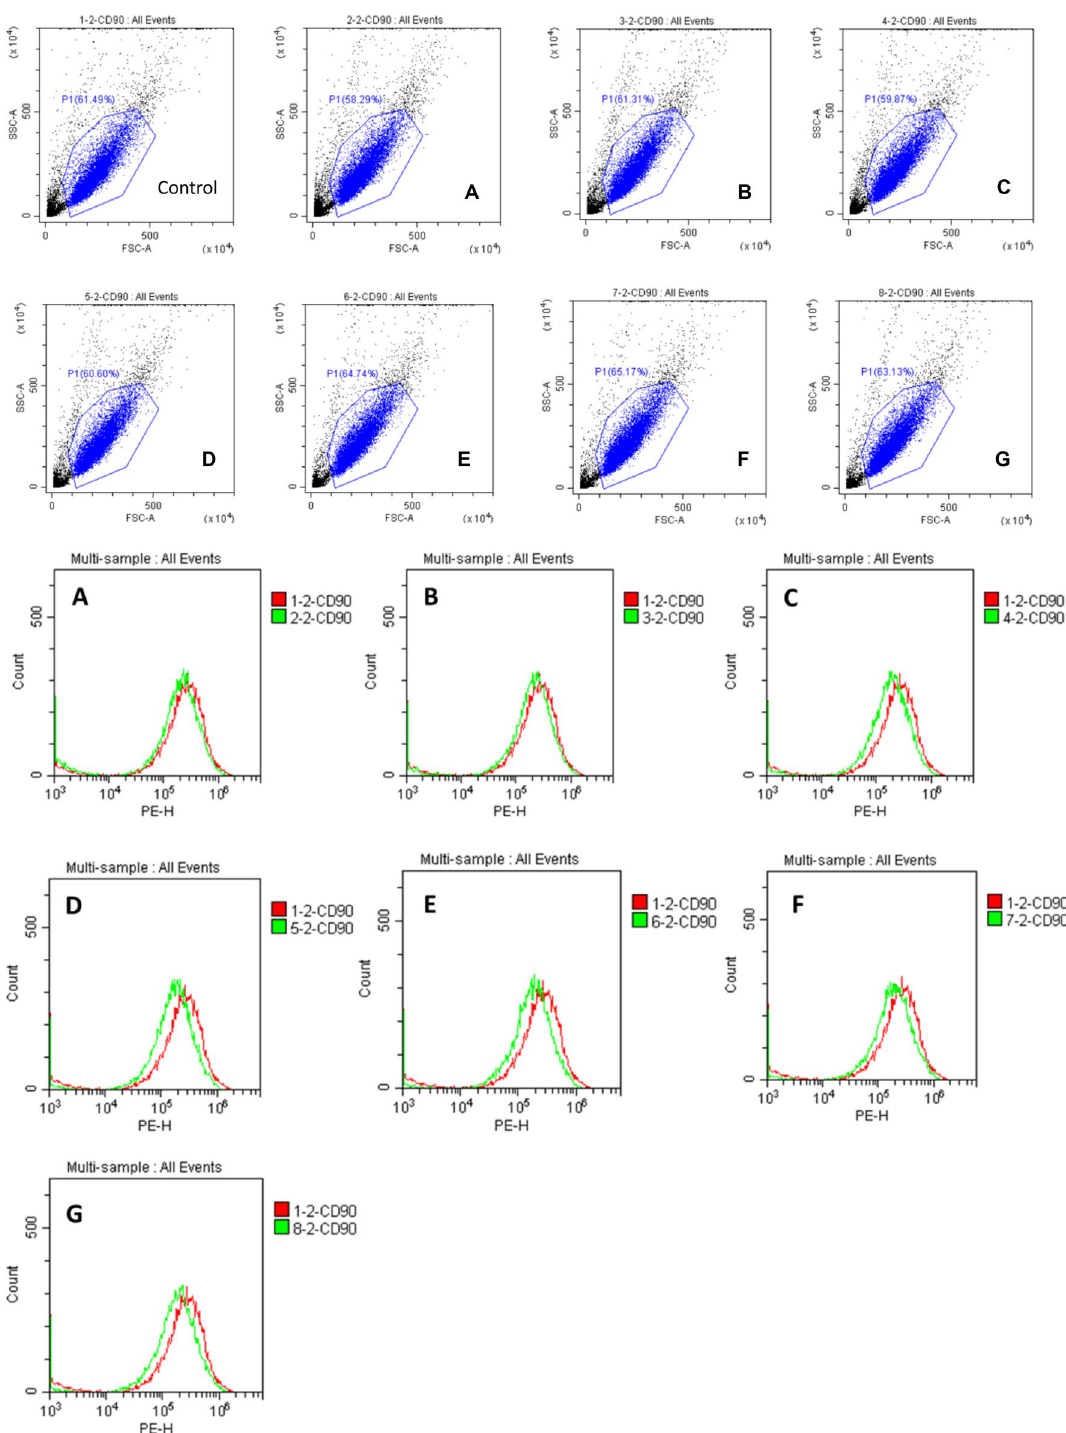
Figure 3. Fluorescence curves of CD90 in skin-derived stem cells (SDSCs) subjected to treatment with seven laser intensities. ( a ) 5 μJ for 2 s; ( b ) 20 μJ for 2 s; ( c ) 20 μJ for 10 s; ( d ) 30 μJ for 2 s; ( e ) 30 μJ for 10 s; ( f ) 40 μJ for 2 s; and ( g ) 40 μJ for 10 s The upper portion of the figure indicates the positive cells in the indicated region. In the lower portion, the red line represents the control group and green line represents the experimental group. The x-axis indicates the fluorescence intensity and the y-axis denotes the cell count. The data are shown in Supplementary Table